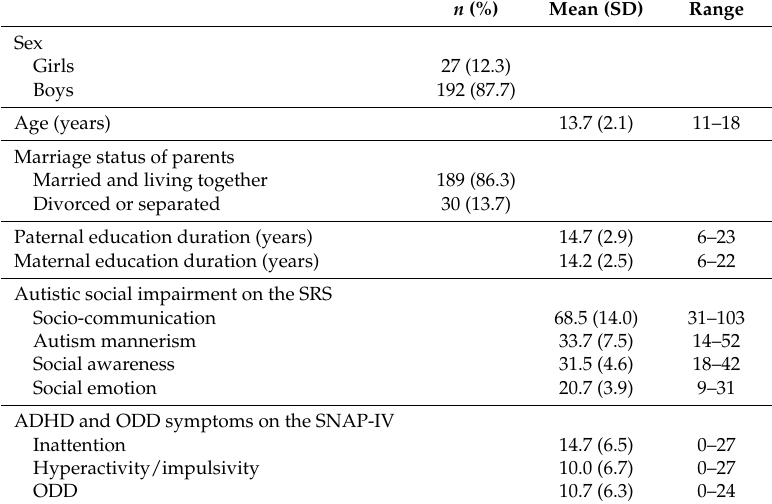
Table 1. Demographic characteristics, autistic social impairment, and ADHD and ODD symptoms ( n = 219).